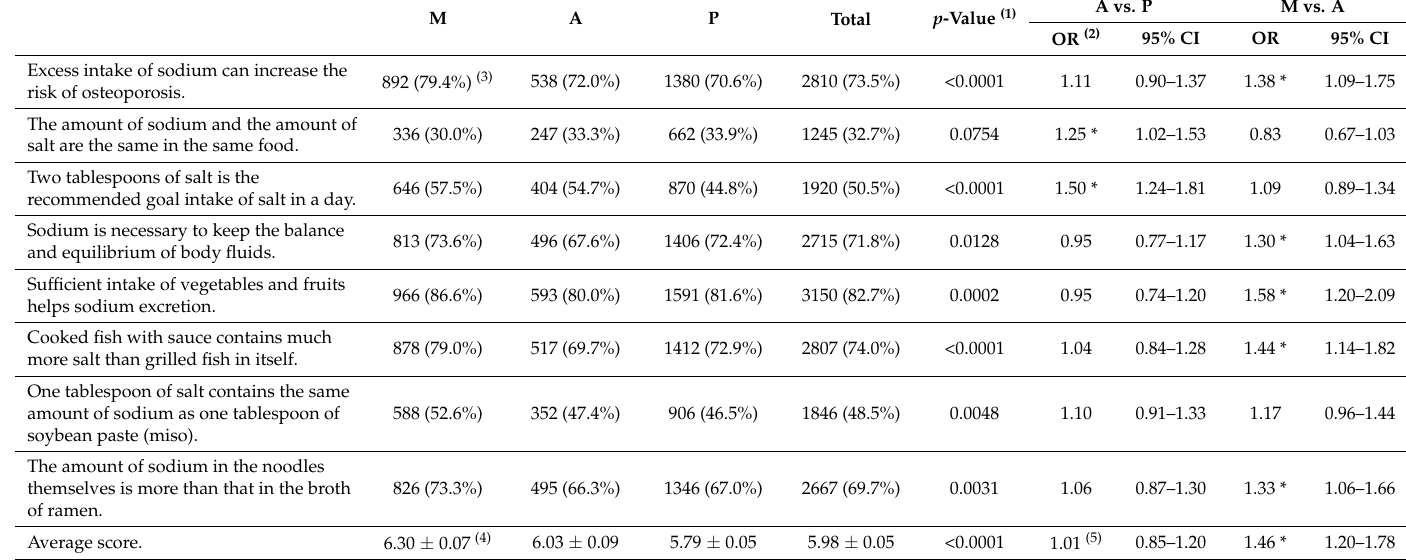
Table 5. The percentage of correct answers and the nutritional knowledge scores related to sodium intake according to the stages of change. A vs. P M vs. A M A P Total p -Value (1) OR (2) 95% CI OR 95%